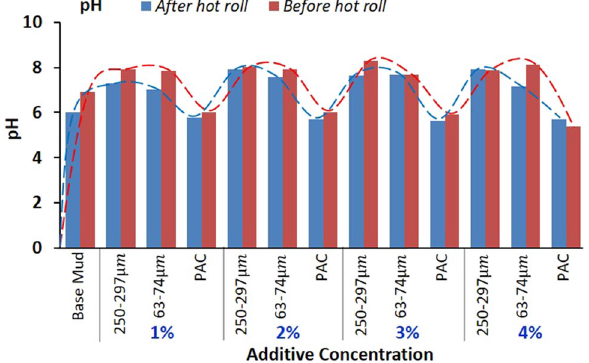
Fig. 17 A comparative analysis of pH at varying concentrations before and after hot